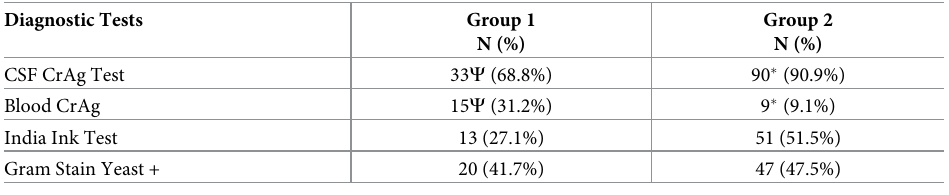
Table 3. CM diagnostic tests among CM confirmed